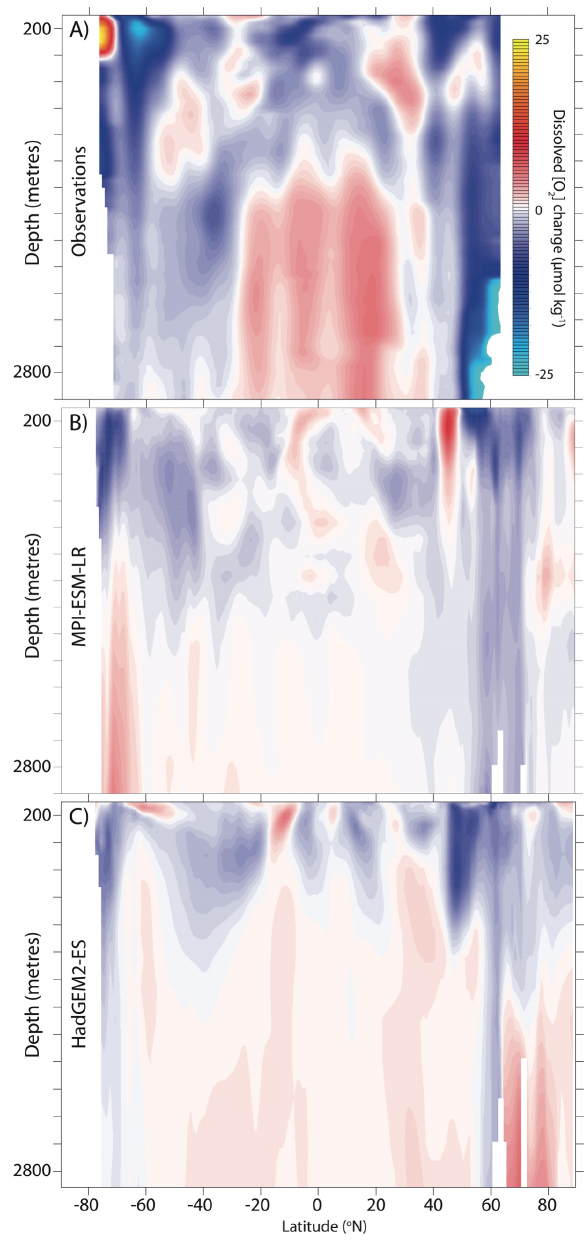
Fig. 4. Zonal mean change ( ∼ 1992 minus ∼ 1970) in [O 2 ] (µmolkg − 1 ) as a function of latitude and depth from (A) observations (Helm et al., 2011), and historical integrations of (B) MPI-ESM-LR and (C) HadGEM2-ES.